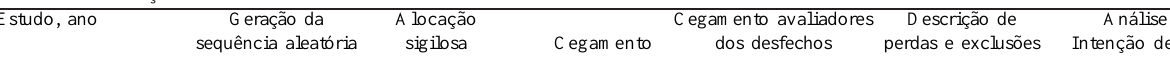
Tabela 3. Avaliação do risco de